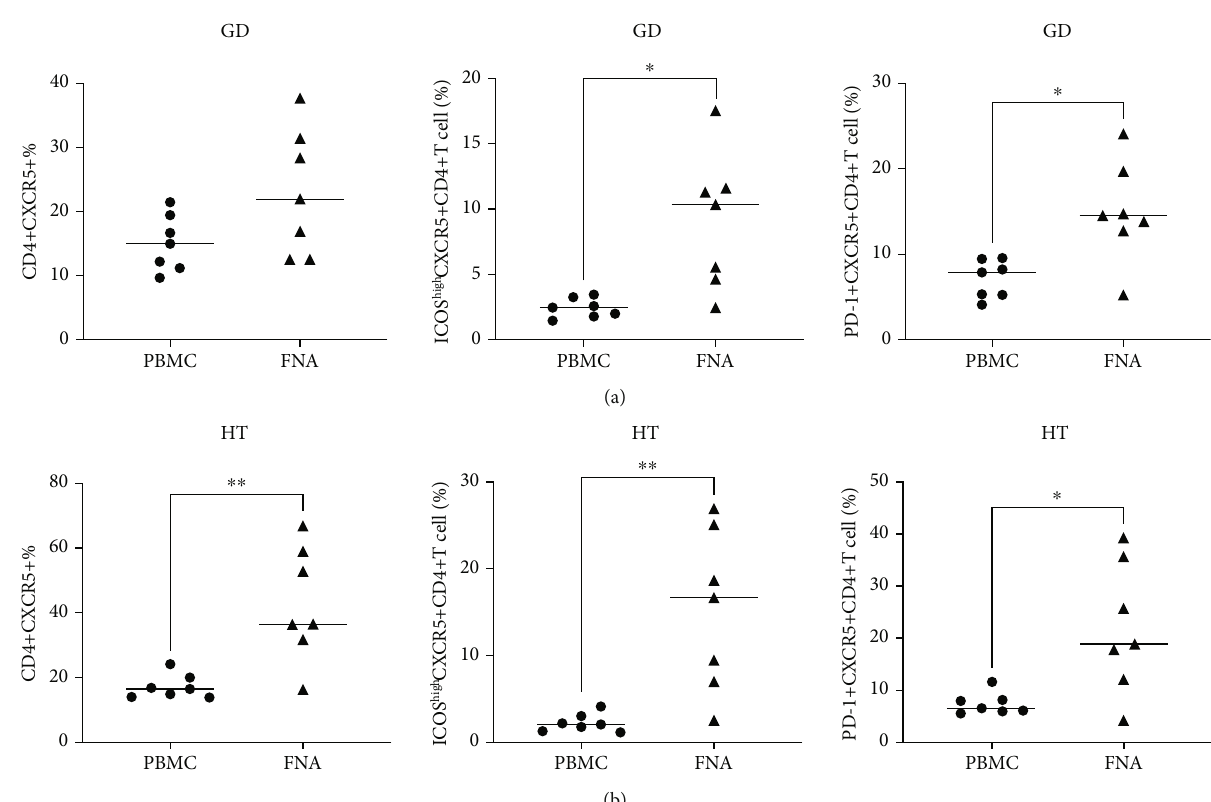
Figure 6: The frequency of Tfh cells in the circulation and thyroid in GD and HT patients. (a) The frequencies of CD4 + CXCR5 + , CD4 + CXCR5 + ICOS high , and CD4 + CXCR5 + PD-1 + Tfh cells in circulation and thyroid tissue in GD patients. (b) The frequencies of CD4 + CXCR5 + , CD4 + CXCR5 + ICOS high , and CD4 + CXCR5 + PD-1 + Tfh cells in circulation and thyroid tissue in HT